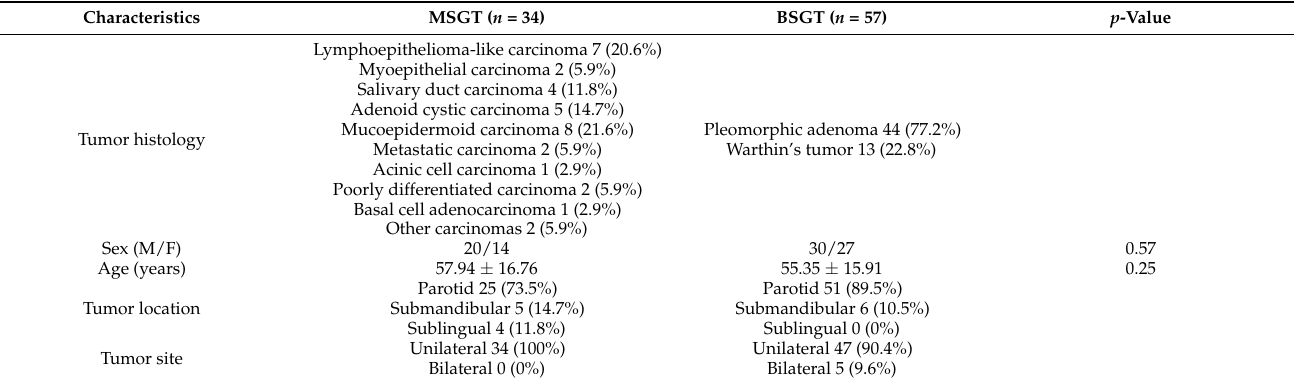
Table 1. General characteristics of the patient cohort. Two-tailed unpaired student t -test was used to evaluate differences in characteristics across MSGTs and